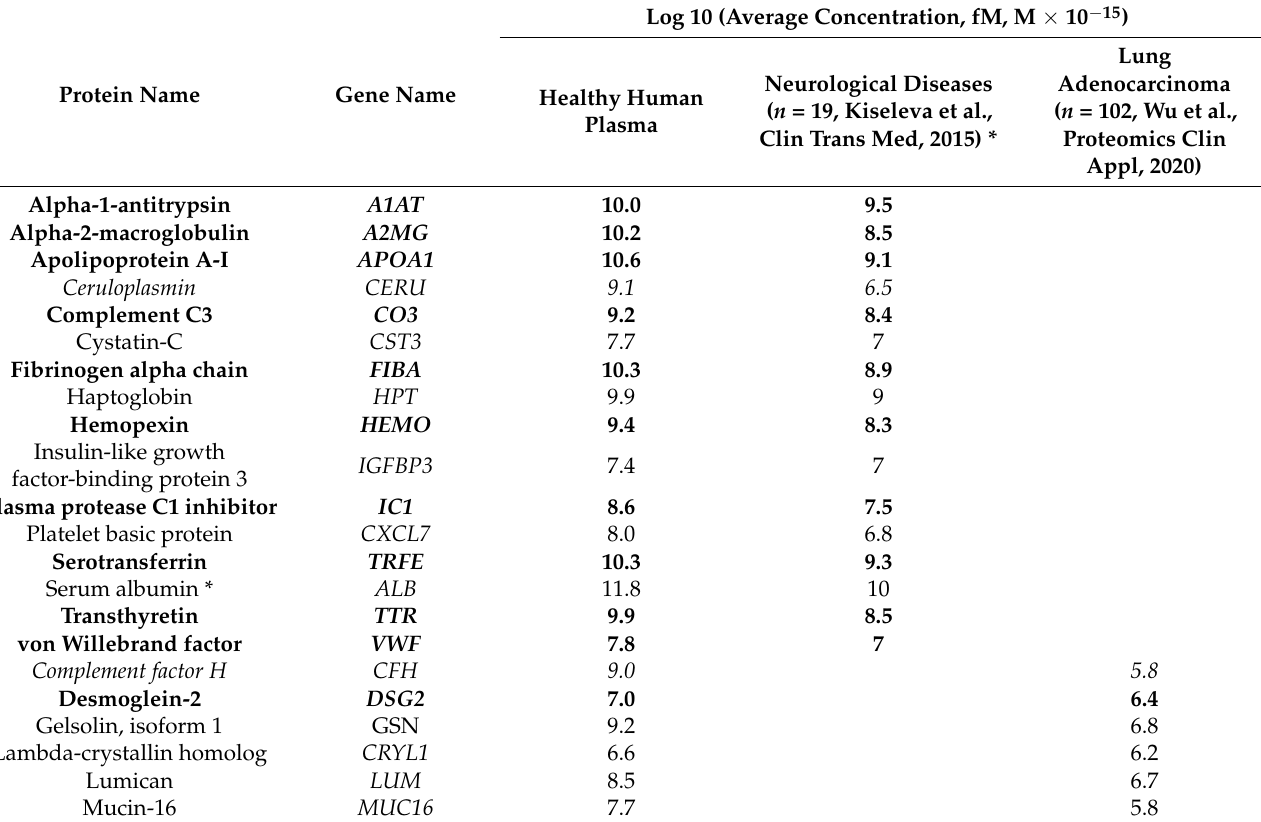
Table 2. Comparison of protein concentrations in healthy individuals and patients with pathologies obtained using the multiple reaction monitoring method. The cells where protein concentrations differed by more than two orders of magnitude are shown in blue. The most stable proteins in the plasma of healthy volunteers retrieved via meta-analysis are displayed in bold